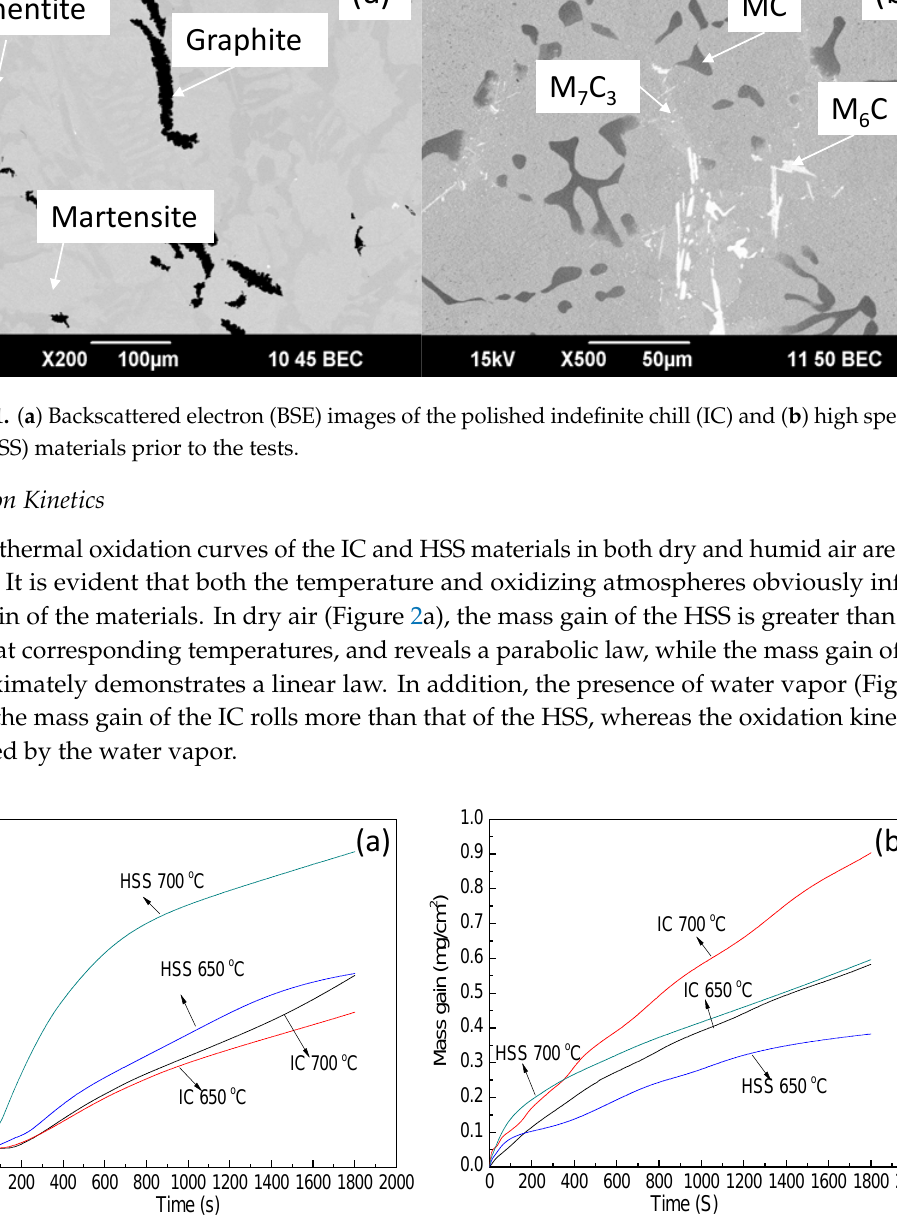
Figure 2. Isothermal oxidation curves of the IC and HSS materials in both ( a ) dry and ( b ) humid air.